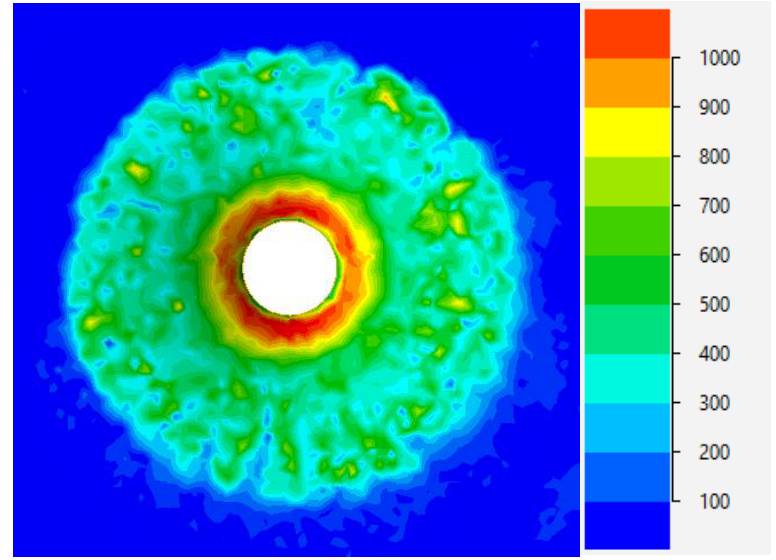
Figure 12. Computed plot of the principal stress 1 (analysis in QForm) (source : author).